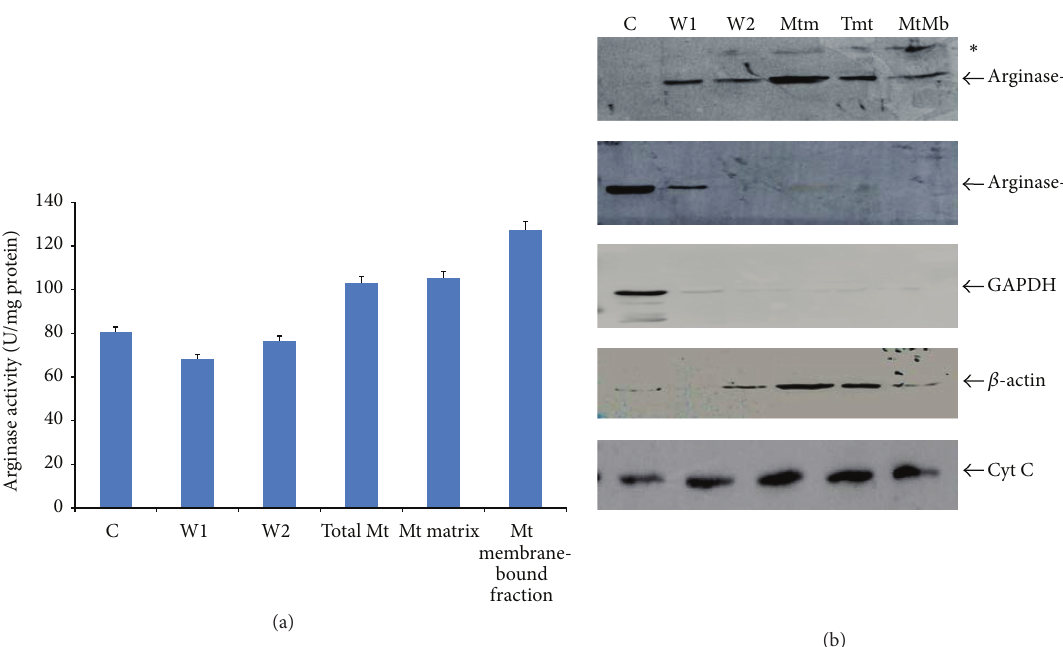
Figure 3: Analysis of arginase isoforms in subcellular fraction of liver of Mus musculus . (a) Histogram represents activity of arginase in different subcellular fractions and (b) shows western blot analysis of cytosolic fraction, total mitochondria, mitochondrial matrix, and mitochondrial outer membrane fractions probed with anti-arginase-II, anti-arginase-I, anti-GAPDH, anti- 𝛽 -actin, and anti-cytochrome C (from top to bottom). The mitochondrial arginase was not observed in cytosolic fraction, whereas it was detected in mitochondrial outer membrane fraction (KCl-treated fraction). The anti-arginase-I did not show cross reactivity with mitochondrial fractions as well as mitochondrial membrane-bound fraction. It clearly indicates that mitochondrial membrane-bound arginase is associated with mitochondrial arginase-II. C = cytosolic fraction, W1 = first wash of total mitochondrial fraction with homogenizing medium, W2 = second wash of total mitochondrial fraction with homogenizing medium, Mtm = mitochondrial matrix fraction (after KCl wash), Tmt = total mitochondrial fraction (before KCl treatment), and MtMb = mitochondrial outer membrane fraction (KCl-washed supernatant). ∗ The variant that is immunoreactive with